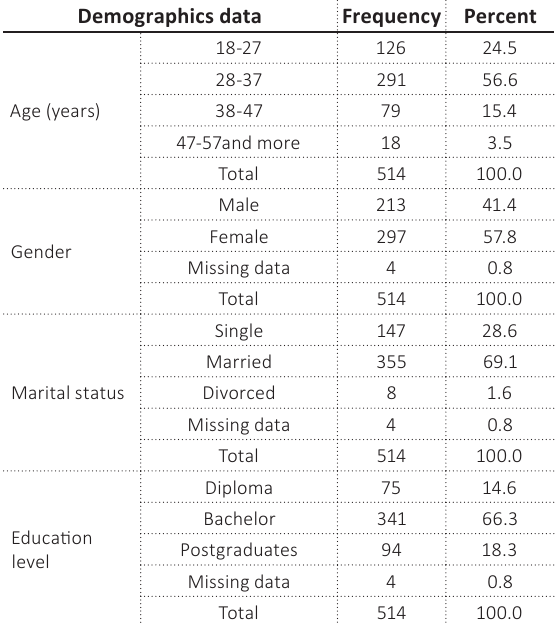
Table 2. Participant